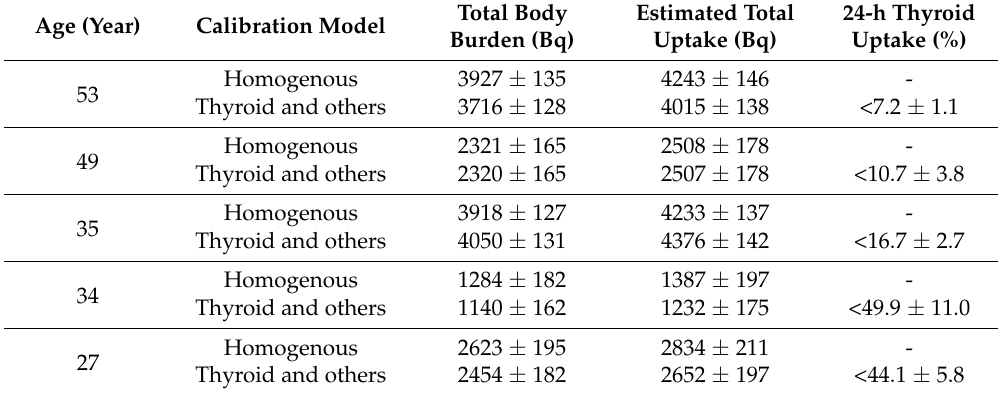
Table 2. Measurement of total body burden values; estimated total uptake and 24-h thyroid uptake of 131 I, estimated from homogenous and two compartments calibrations. The total body burden was at 11:30 on 16 March 2011.